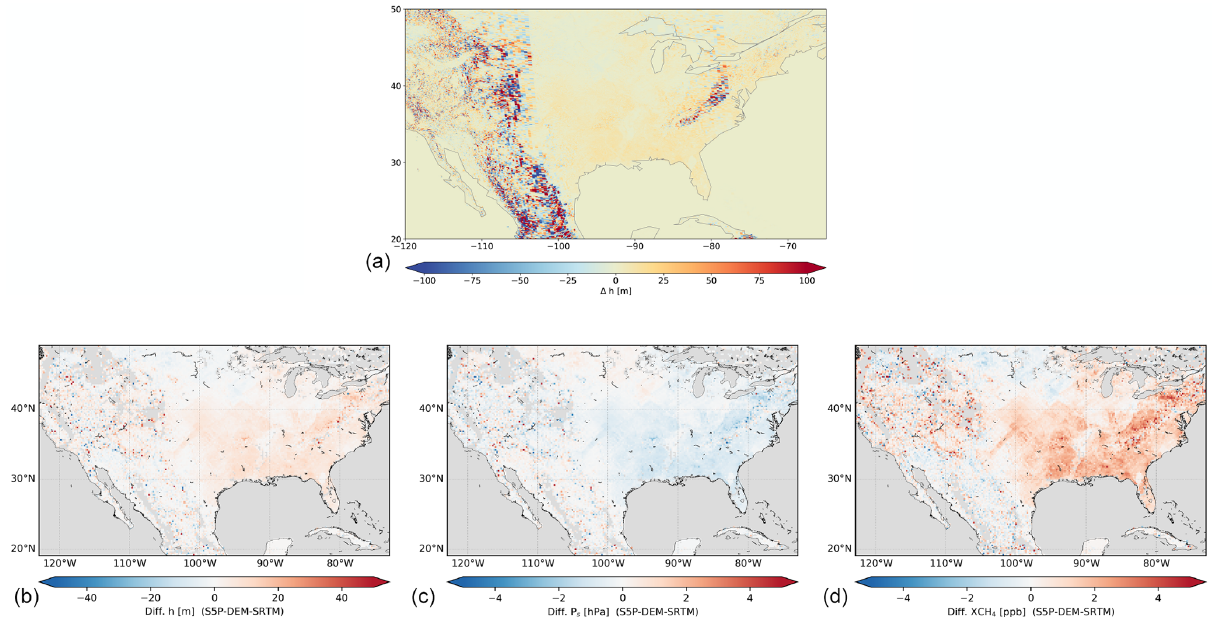
Figure 2. (a) Altitude difference between S5P-DEM and SRTM collocated to TROPOMI pixels on 5 May 2019 (orbits 8077, 8078, 8079). (b–d) Altitude, surface pressure and XCH 4 differences averaged over a year, with custom quality filtering for the TROPOMI XCH 4 retrievals, in a 0 . 2 ◦ × 0 . 2 ◦ grid over the United States (20–50 ◦ N, 65–120 ◦ W).